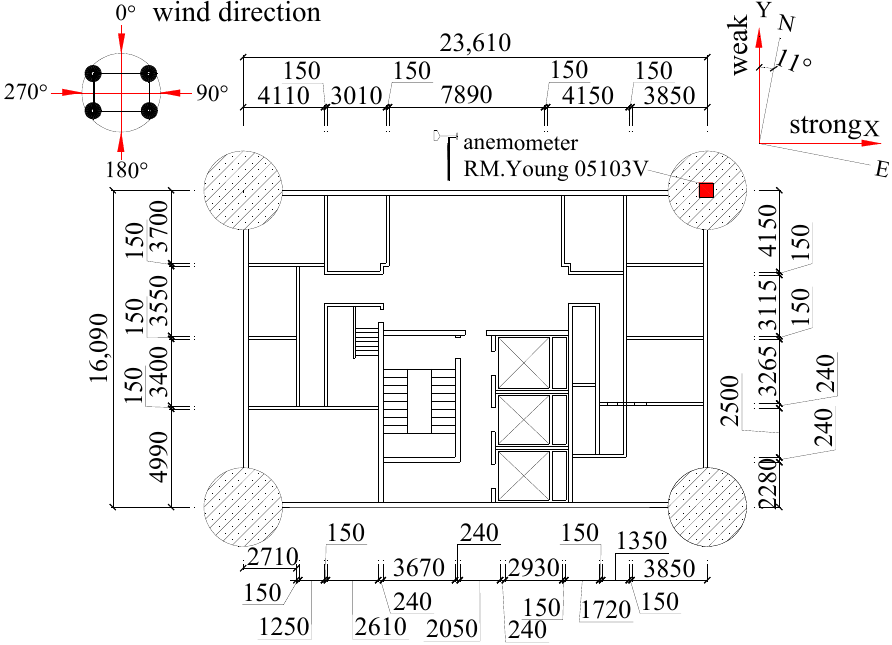
Figure 4. Plan of installation position of 05103V anemometer on the roof of high-rise building.